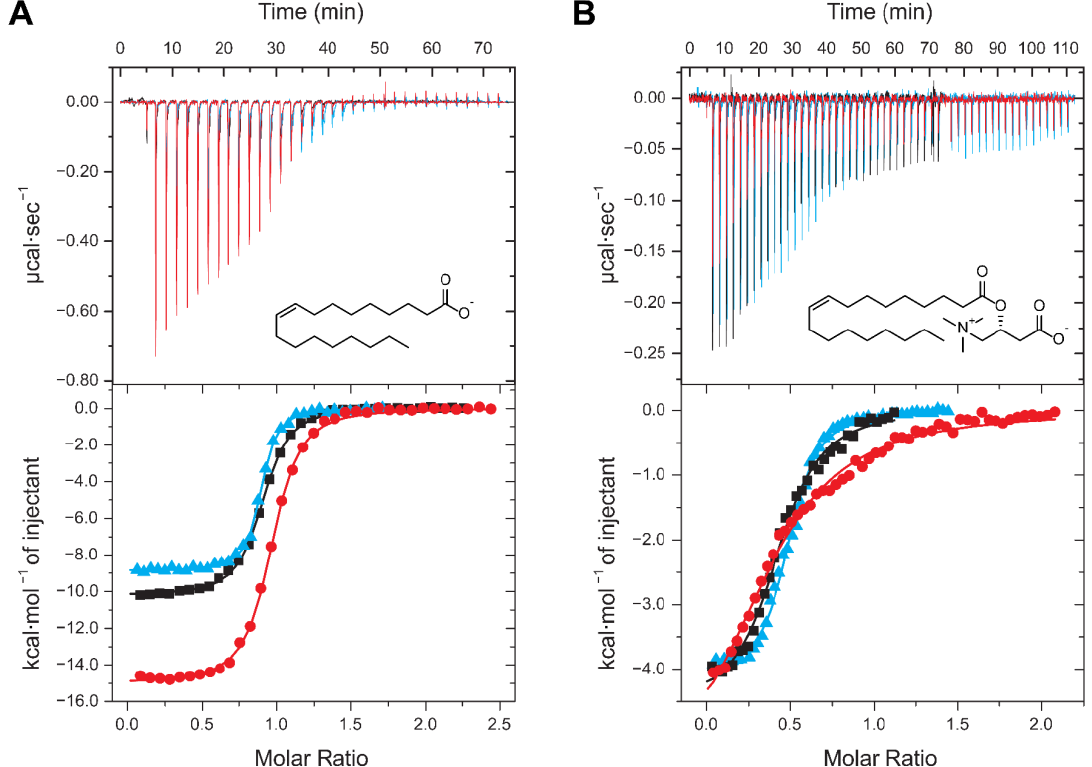
Figure 7. Superposition of the ITC thermograms for heart-type fatty acid-binding protein (FABP3) titrated with ( A ) C18:1(n-9) c and ( B ) C18:1(n-9) c -carnitine at three different temperatures: 16 (cyan), 25 (black), and 37 °C (red).